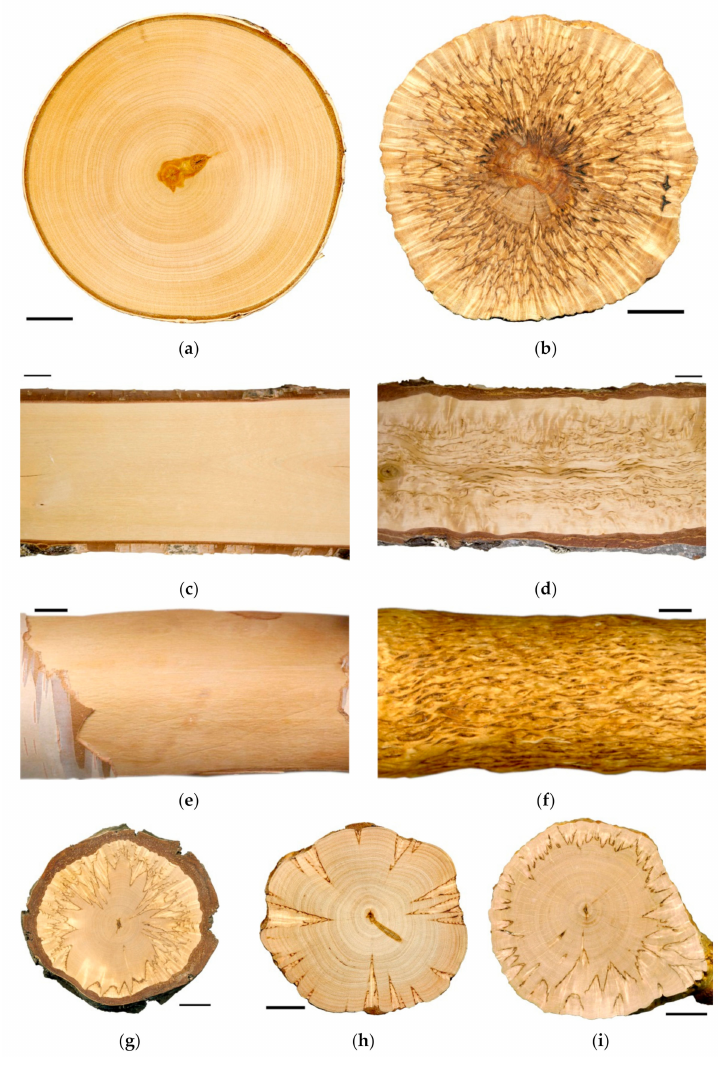
Figure 1. Cross—( a , b , g – i ) and longitudinal ( c , d ) wood sections, debarked wood surface ( e , f ) of B . pendula var. pendula ( a , c , e ) and figured B . pendula var. carelica ( b , d , f – i ) trees. Bar: 2